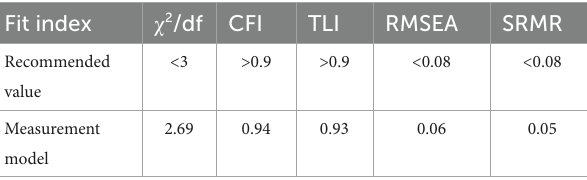
TABLE 2 Goodness-of-fit indices of the measurement